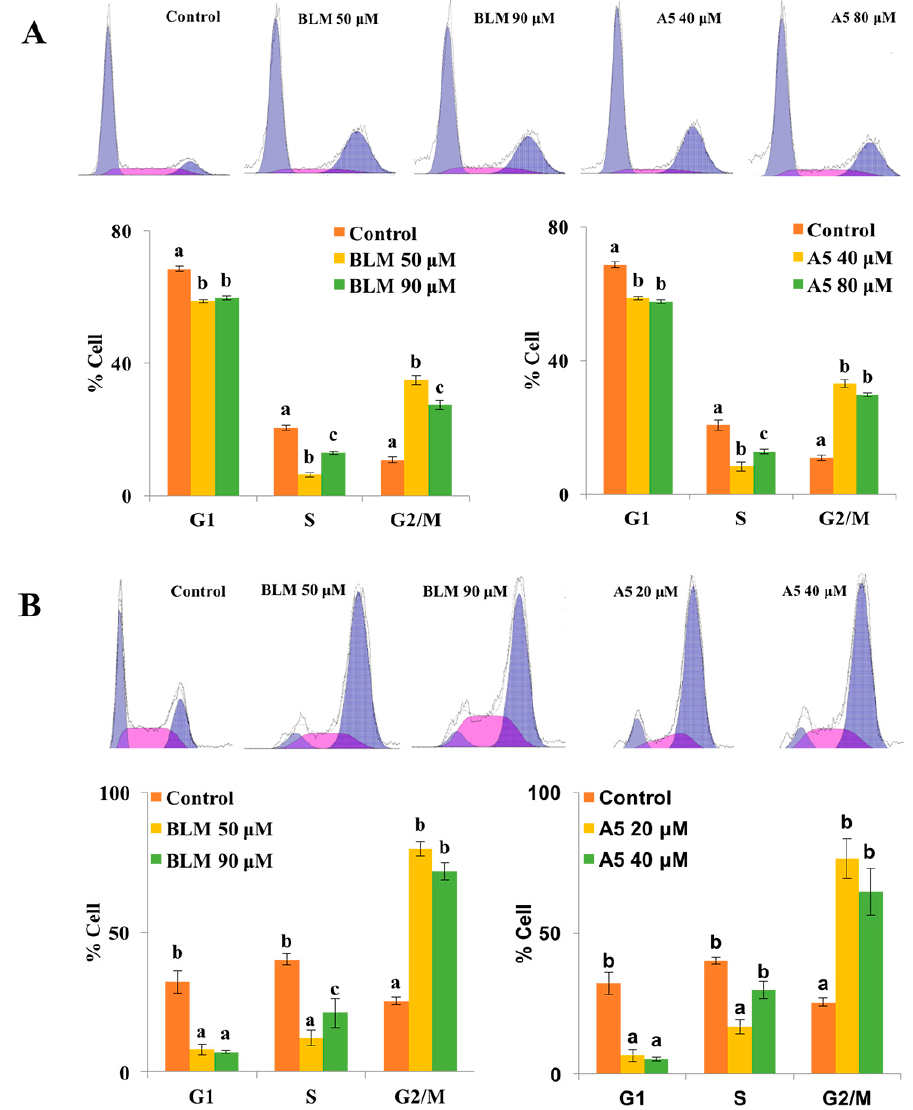
Figure 4. Cell cycle distributions of A549 ( A ) and HCT116 cells ( B ) after treatments with BLM or A5. The cells were seeded in six-well plates for 24 h, and then the cells were treated with various concentrations of BLM or A5. (Panel A) the A549 cell line, 50 μ M or 90 μ M of BLM; 40 μ M or 80 μ M of A5; (Panel B) the HCT116 cell line, 50 μ M or 80 μ M of BLM; 20 μ M or 40 μ M of A5. After 24 h of treatments, cells were harvested and subjected to cell cycle analyses as described in the Materials and Methods section. All data represent mean ± S.D. ( n = 3). Different letters (a, b, or c) in each cell cycle phase mean significant differences (ANOVA with Turkey test for multiple comparisons, p < 0.05).